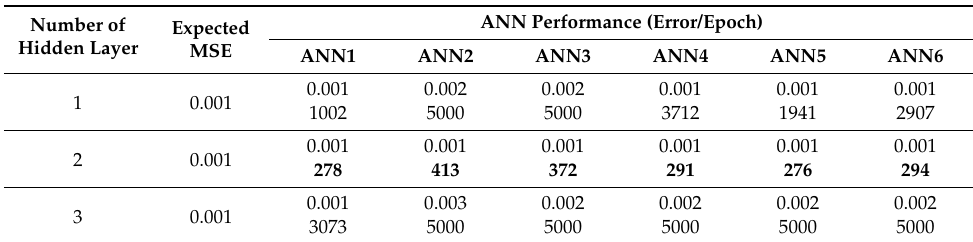
Table 3. Experiments for the number of hidden